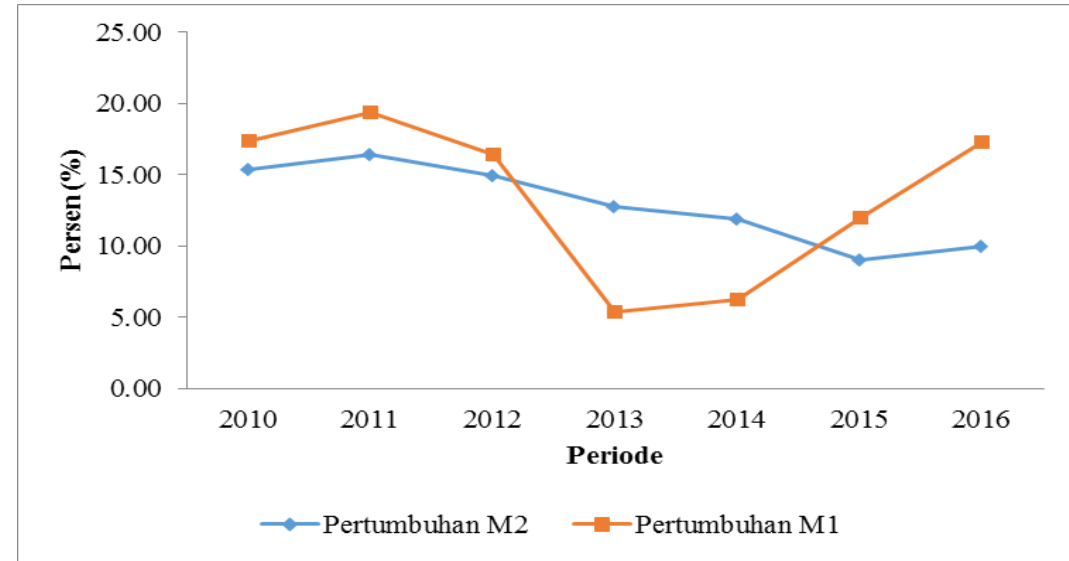
Figure 1: Narrowand Broad Money in Indonesia 2010-2016 (in percent) Source: Bank